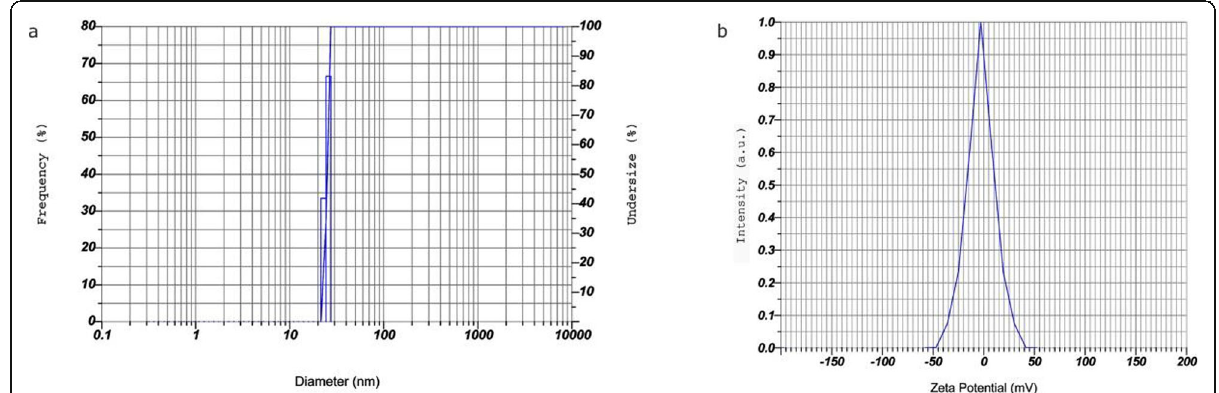
Fig. 4 a Particle size of the green synthesized MgO-NPs using P . marsupium heartwood extract. b Zeta potential of green synthesized MgO-NPs using P . marsupium heartwood